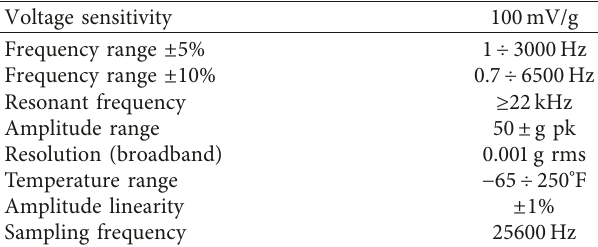
Table 2: Accelerometers’ main characteristics.